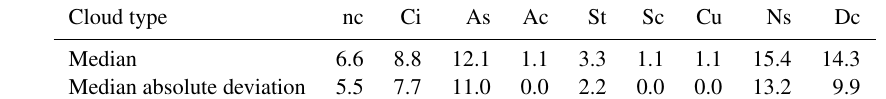
Table 1. Horizontal cloud chord length median and median absolute deviation for each cloud type (km).